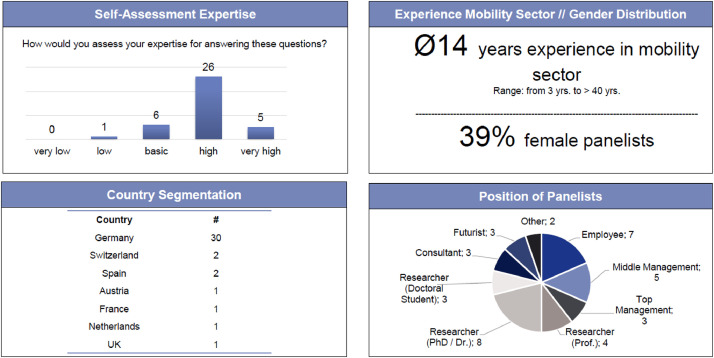
Overview of final panelists [26].